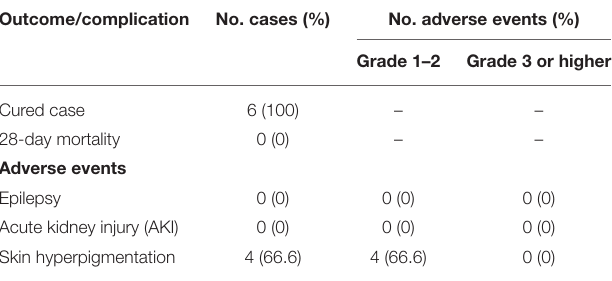
TABLE 5 | Clinical outcomes and